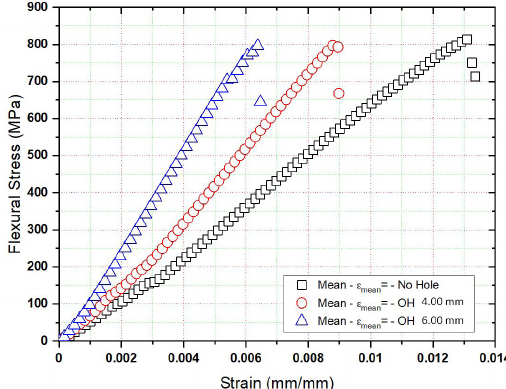
Figure 5. Stress dispersion curves in bending of carbon/epoxy specimens without hole and with hole.